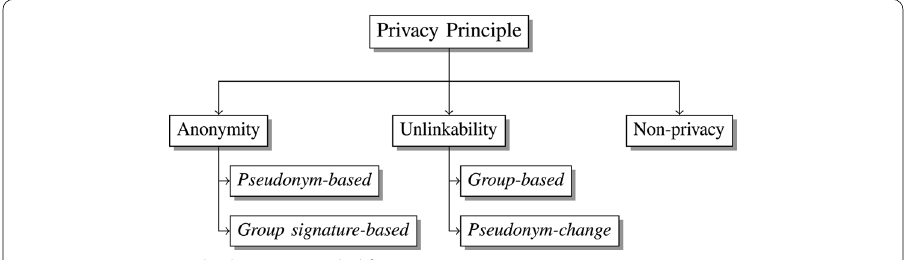
Fig. 13 Privacy principle class in expanded